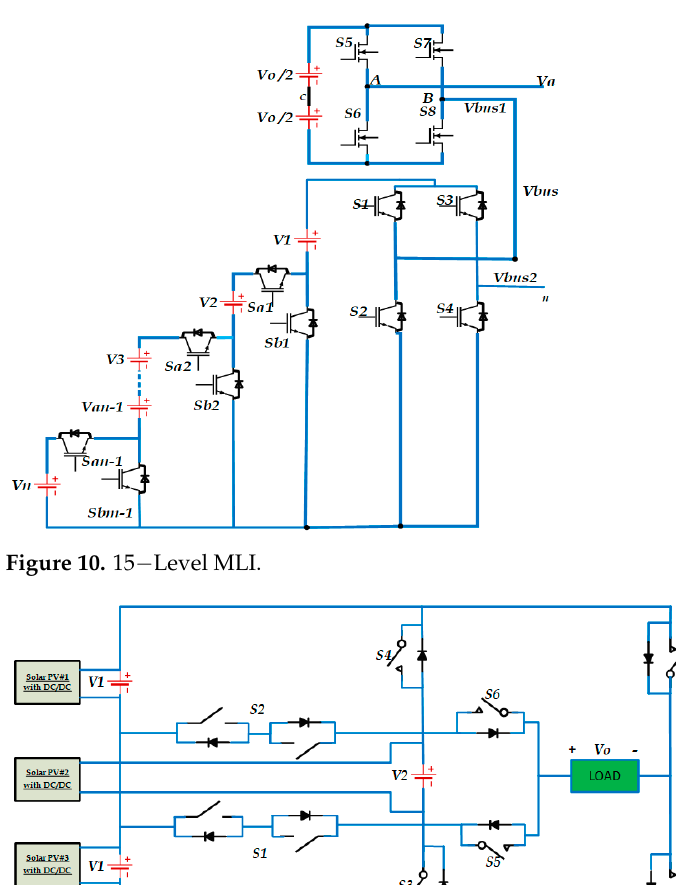
Figure 12. Dual Input Topology.